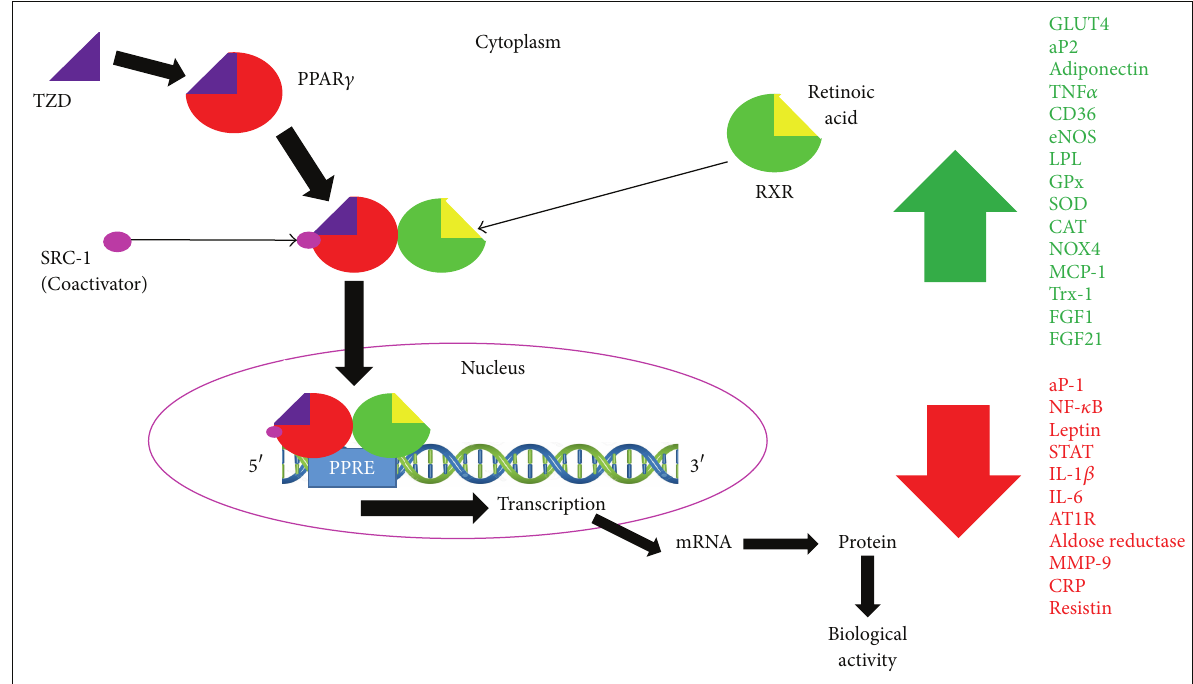
Figure 4: Mechanism of action of PPAR 𝛾 when it is activated by its exogenous ligands thiazolidinediones (TZDs).